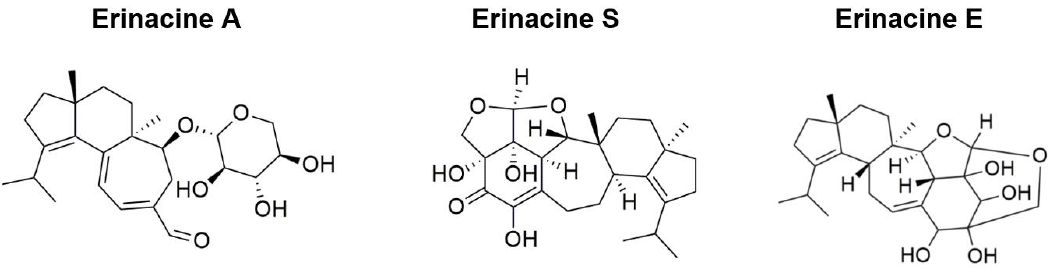
Figure 2. Bioactive compounds isolated from Hericium erinaceus with therapeutic effects on Alzheimer’s disease.